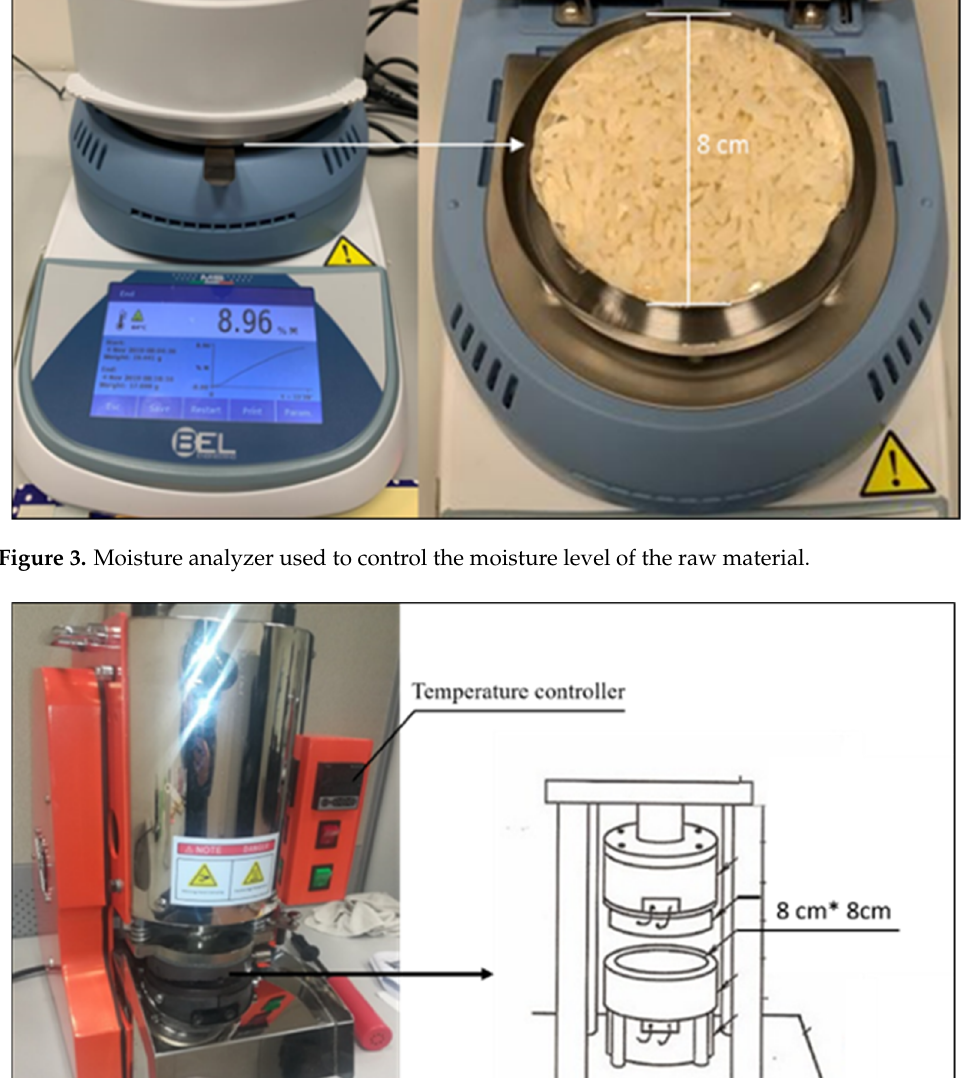
Figure 4. Experimental setup used into produce the proposed new bio-insulation